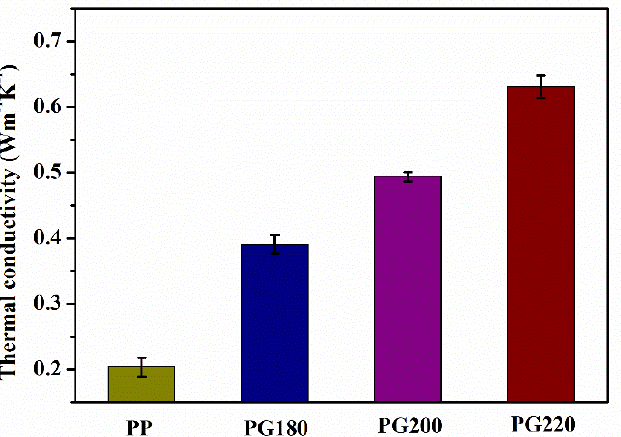
Figure 5. Thermal conductivities of neat PP and PP/GIC composite samples.